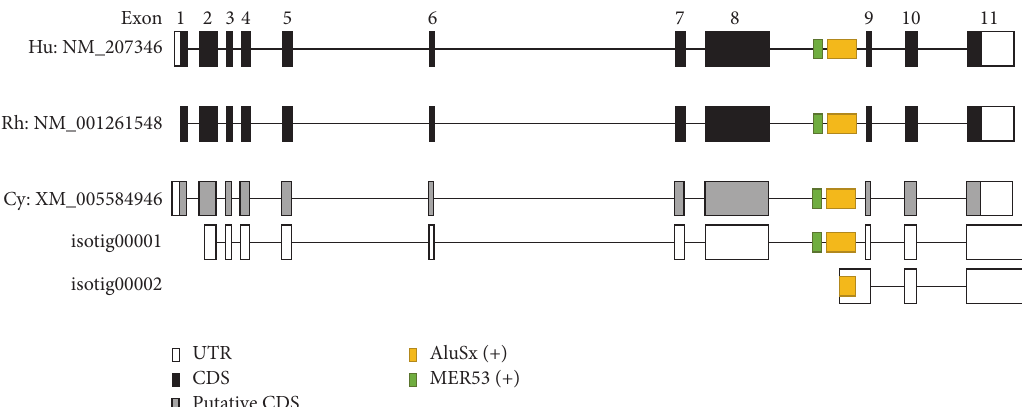
Figure 1: Structural analysis of TSEN54 of human, rhesus, and cynomolgus monkey. Open, closed black, and gray boxes represent the untranslated region of exons, protein coding region, and putative protein coding region, respectively. The sense directed MER54 and AluSx are located on intron 8 of TSEN54